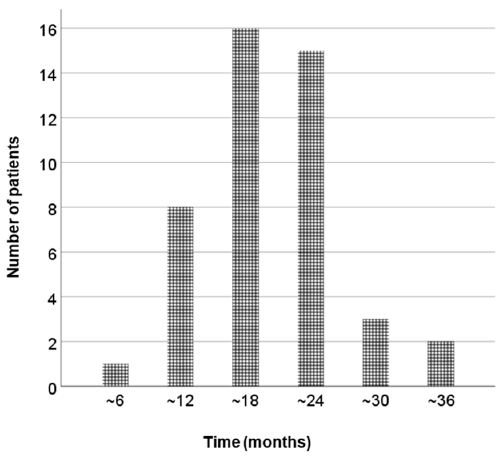
Figure 2. The period before PSA bounce. PSA, prostate-specific antigen.